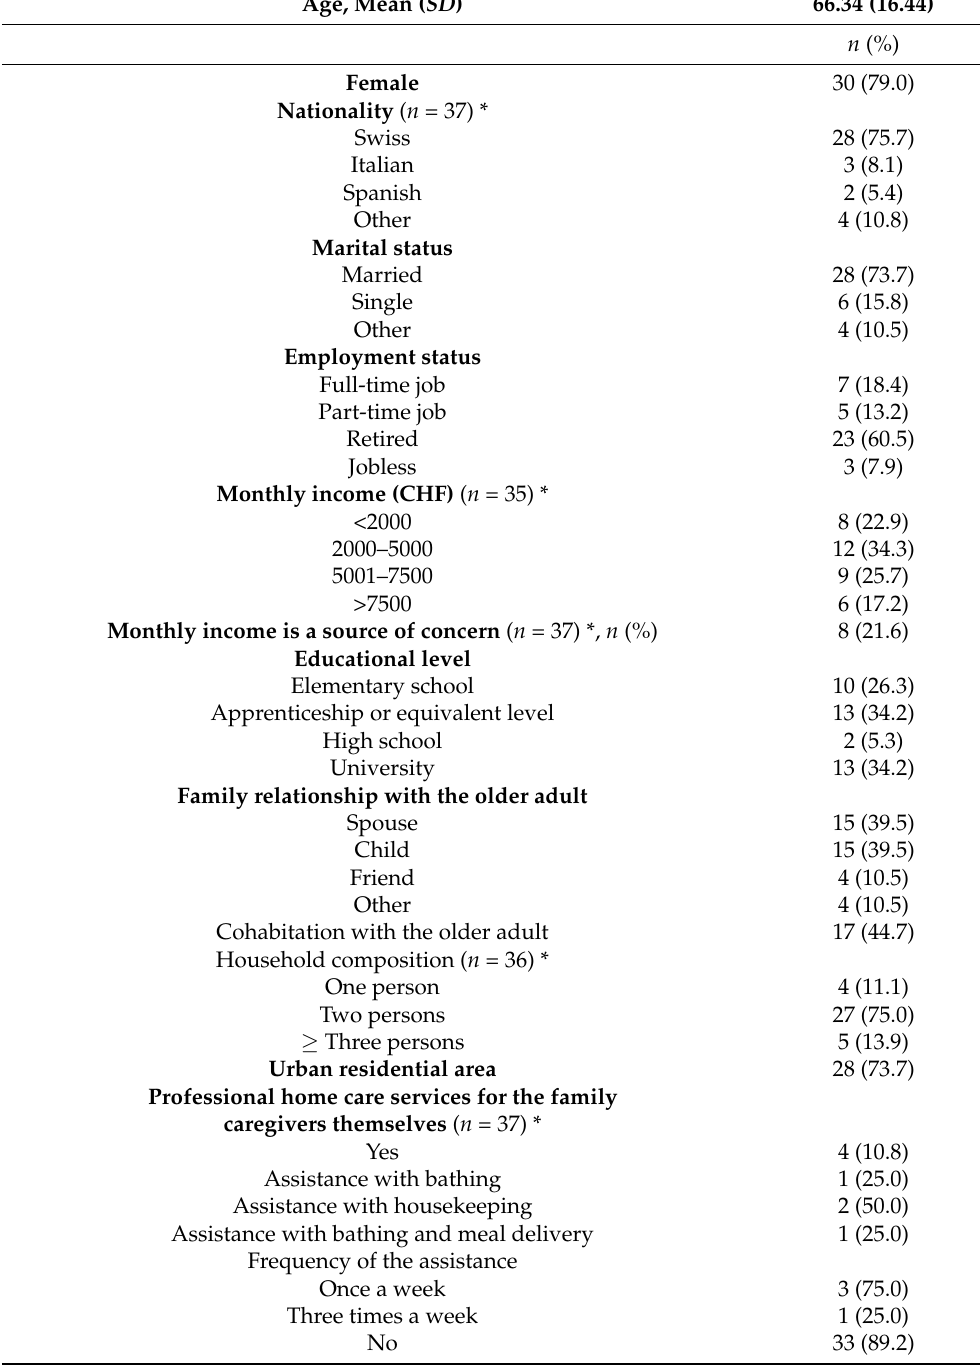
Table 1. Family caregivers’ sociodemographic characteristics ( n =